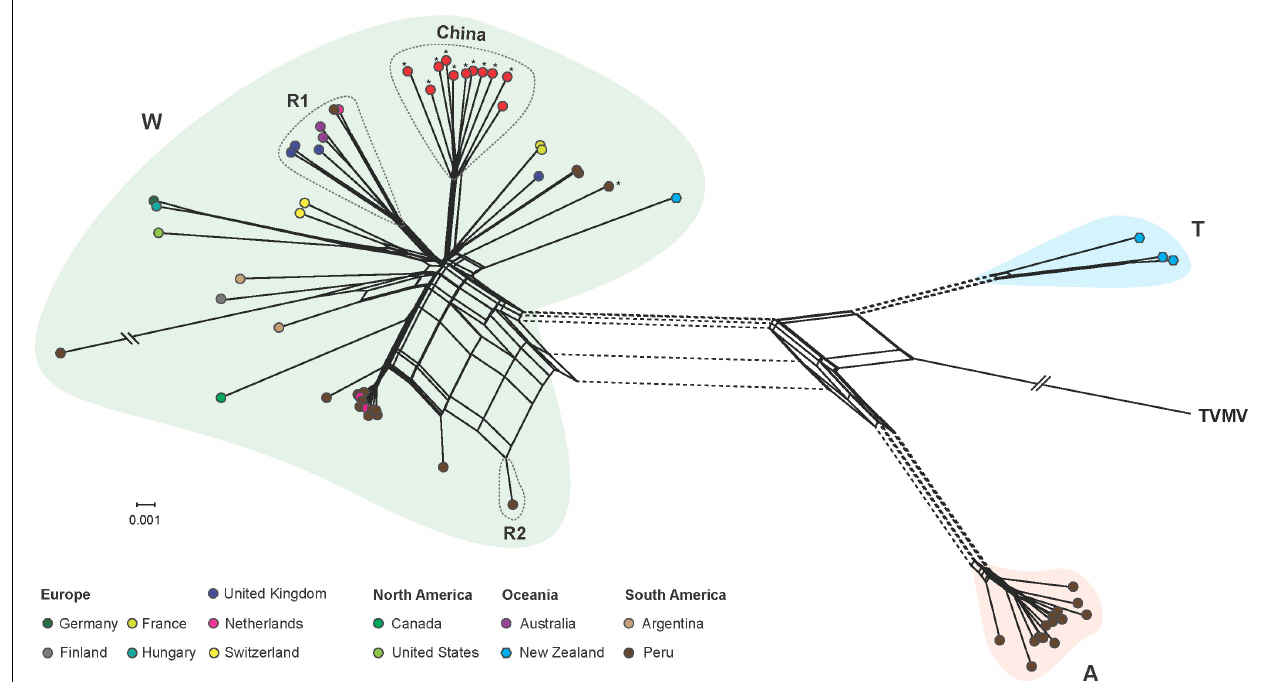
FIGURE 3 | Phylogenetic network inferred from the complete genome of 66 potato virus A isolates. Unique color indicates the geographic origin, as shown in the color key. Phylogenetic groups W (world), A (Andean), and T (tamarillo) were proposed by Fuentes et al. (2021). PVA isolates infecting potato in different regions are indicated by circles, as shown in the color key, and those infecting taramillo are shown in blue hexagons. Isolates sequenced in the study are marked by asterisks. Parallel slashes indicate the branch lengths that were pruned to fit the image size. R1 and R2 indicate recombination group 1 and 2, respectively, which contained recombinants identified by the RDP package. See Table 4 for details of the recombinants. A tobacco vein mottling virus (accession number NC_001768) isolate was used as an